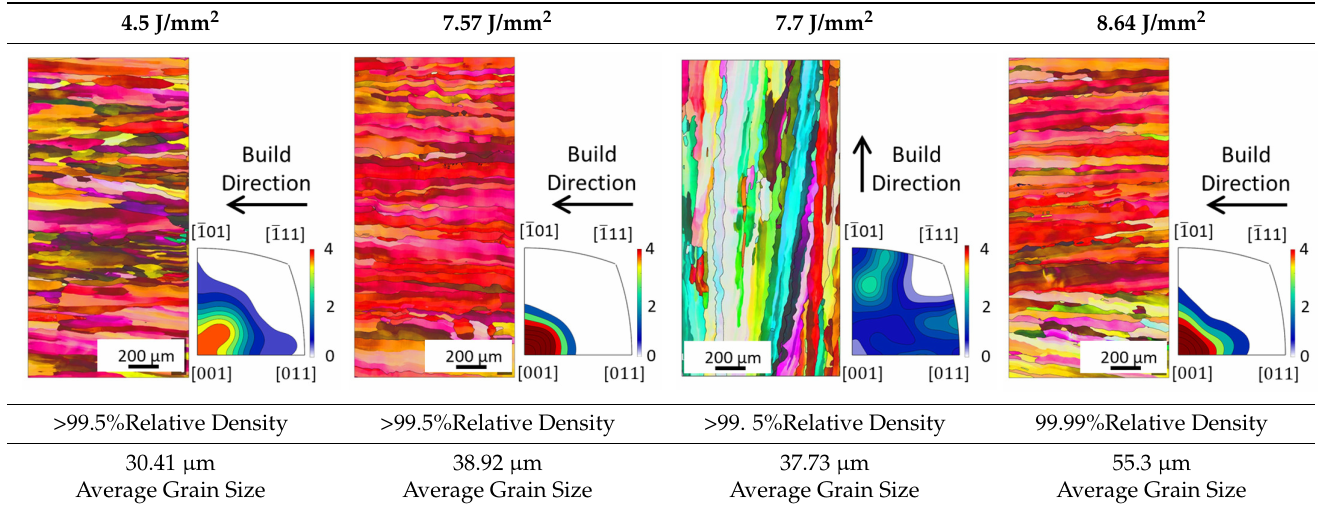
Table 3. Overview EBSD Analysis for different Area Energy